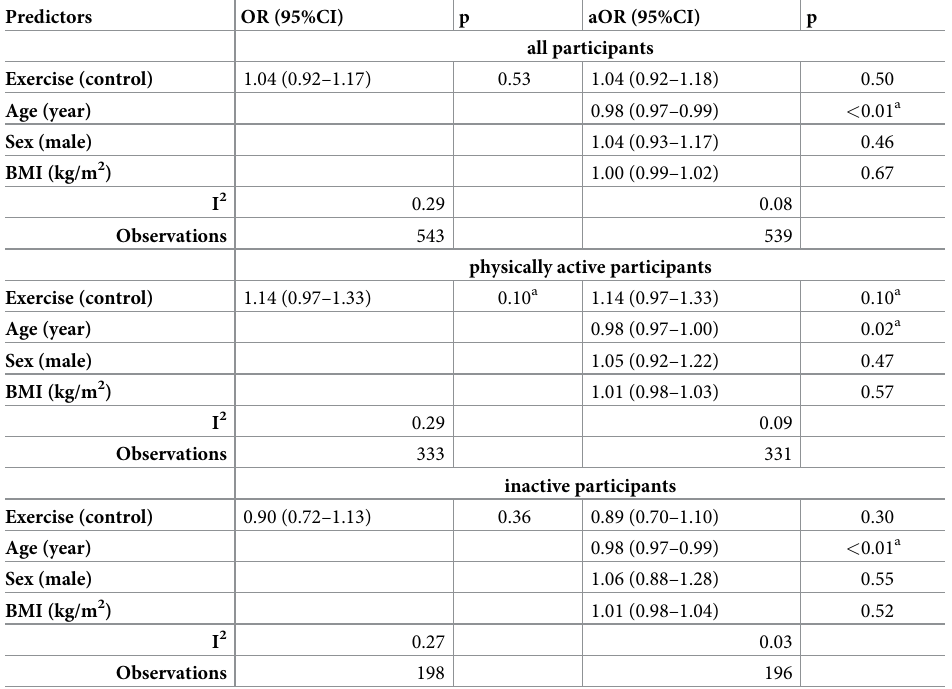
The effect of acute exercise on influenza H1 antibody titer change by physical activity: linear regression (unadjusted and adjusted modelling) on change in antibody titer levels. Estimates are given with 95%CI in parentheses. Predictors are by unit increase (age and BMI) or versus comparator (exercise and sex). BMI = body mass index.